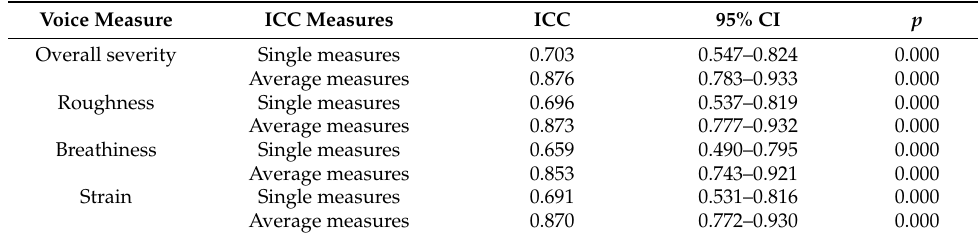
Table 4. Inter-rater reliability of the perceptual